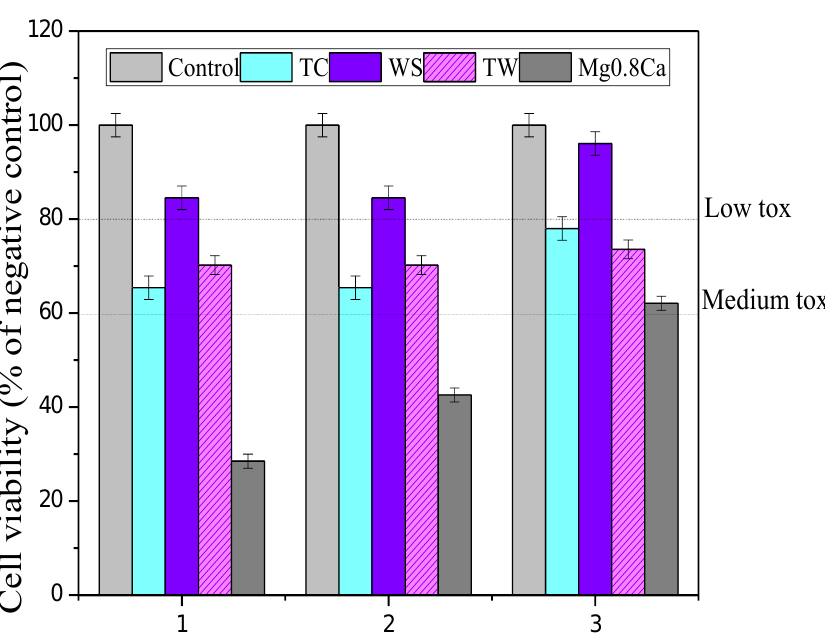
Figure 16. Effect of Mg0.8Ca and coating extracts on the viability of 3T3 cell line determined by MTT assay (1), when extracts were diluted 10 (2) and 100 (3) times as compared to control. For each group, 5 wells per plate were treated identically, and each experiment was performed with at least 3 plates.